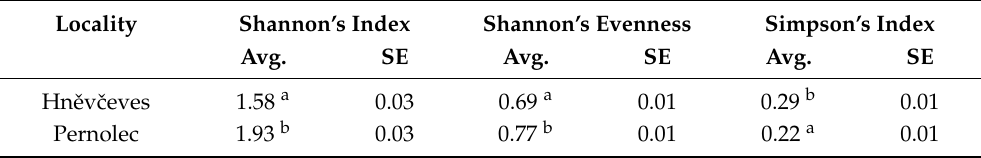
Table 3. Species diversity indices in the localities. Average values (avg.) ± standard error (SE) was assessed over years, treatments and crops. The averages marked by the same letter in individual columns did not significantly differ at α = 0.05 (Scheffe’s